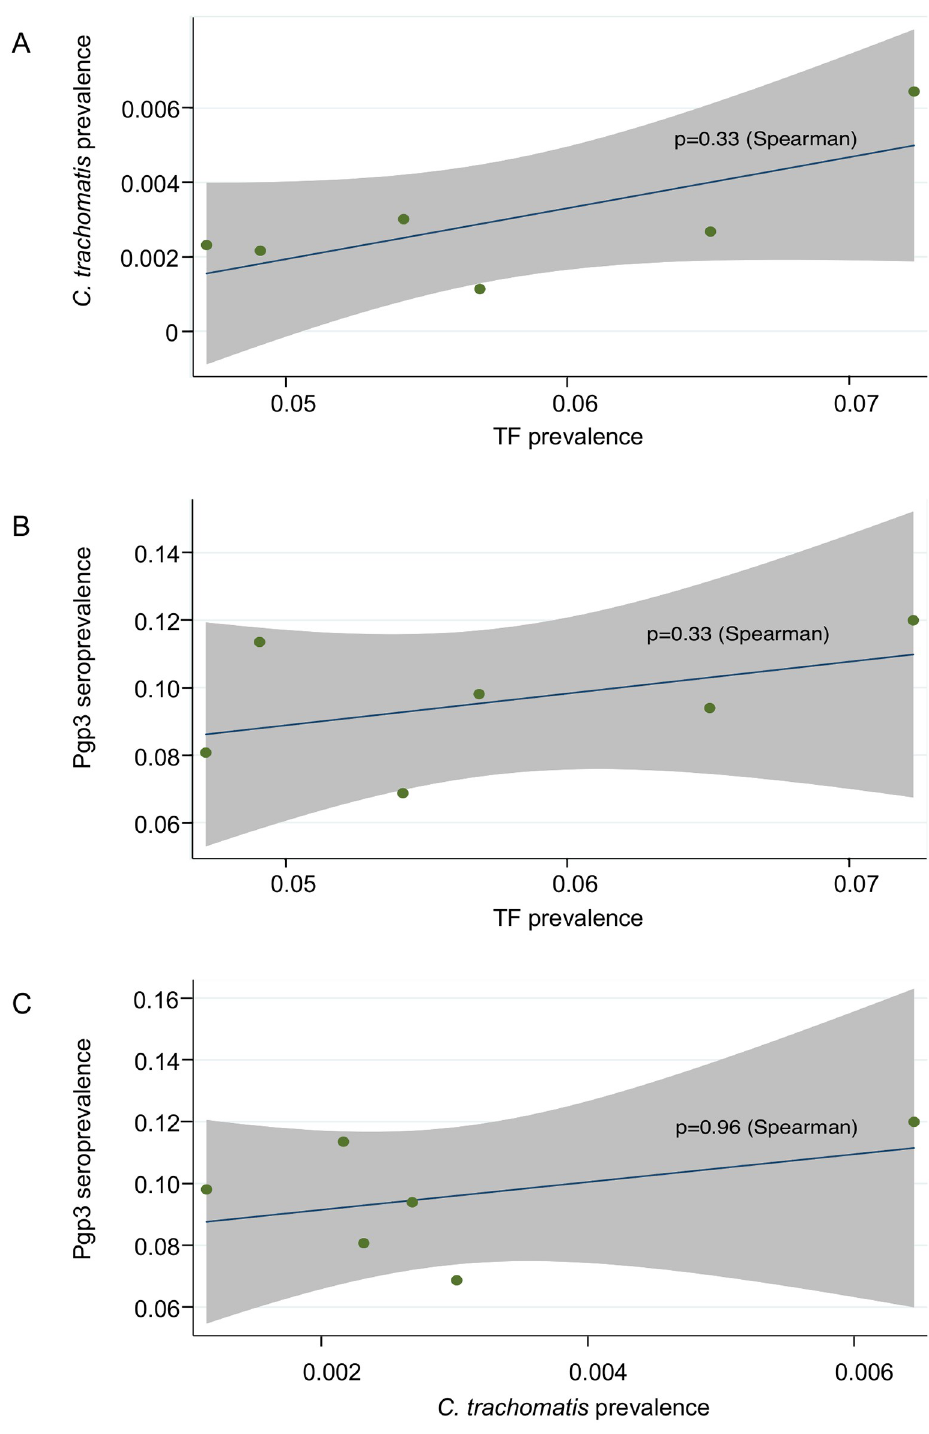
Fig 2. Correlations between EU-summarised prevalence of TF, C . trachomatis infection and anti-Pgp3 antibodies. (A) Correlation of EU-summarised prevalence of TF and C . trachomatis infection. (B) Correlation of EU-summarised prevalence of TF and anti-Pgp3 antibodies. (C) Correlation of EU-summarised prevalence of C . trachomatis infection and anti-Pgp3 antibodies. EUs are represented by green dots. Lines of best fit are shown in blue. Shaded areas denote 95% confidence